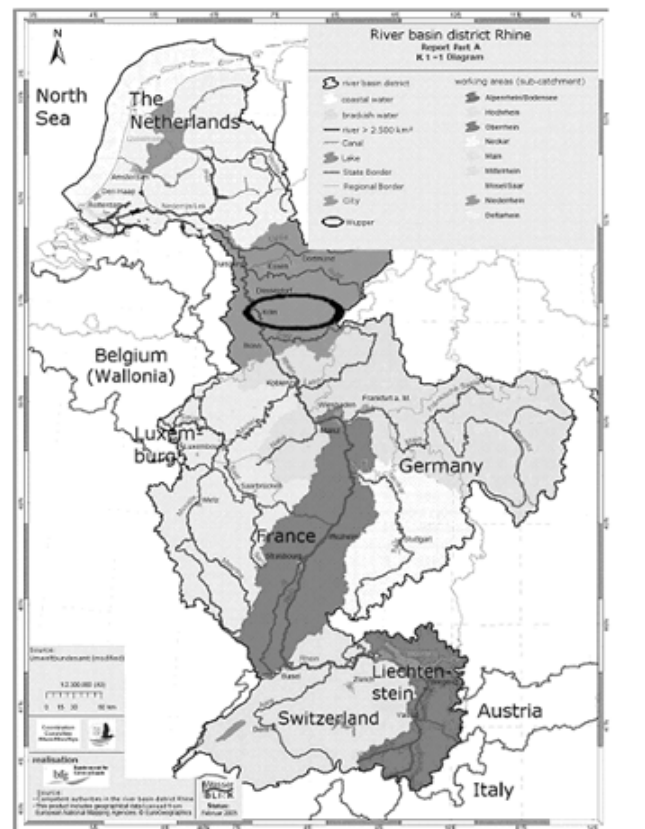
Fig. 1 . Location of the case study area in the German Rhine basin. (Source: German Federal Environmental Agency